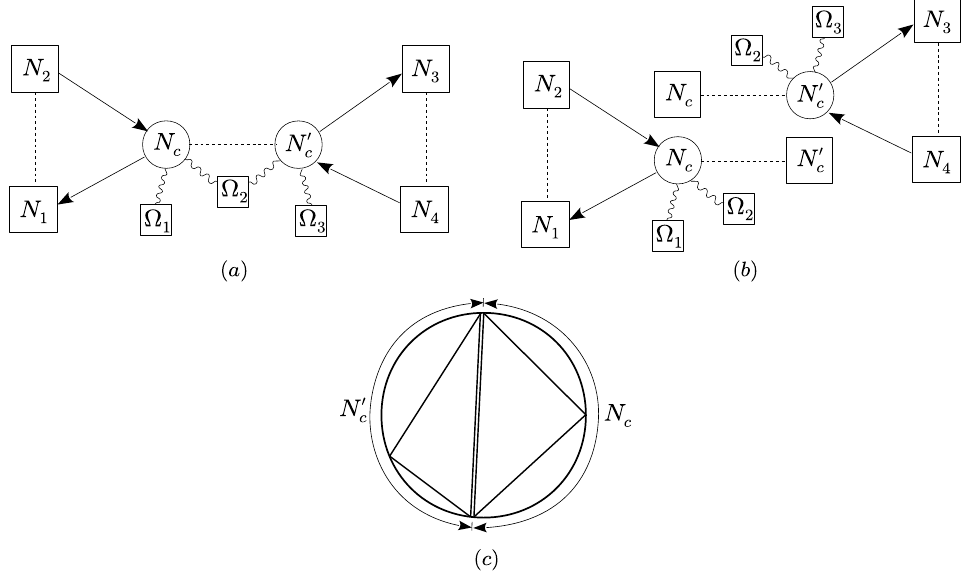
Figure 7 . A two-node quiver ( a ) describes a (0 ; 2) theory obtained by \gluing" two copies of the elementary SQCD ( b ). In the low-energy SCFT this gluing process is nicely represented by gluing inscribed triangles ( c ).